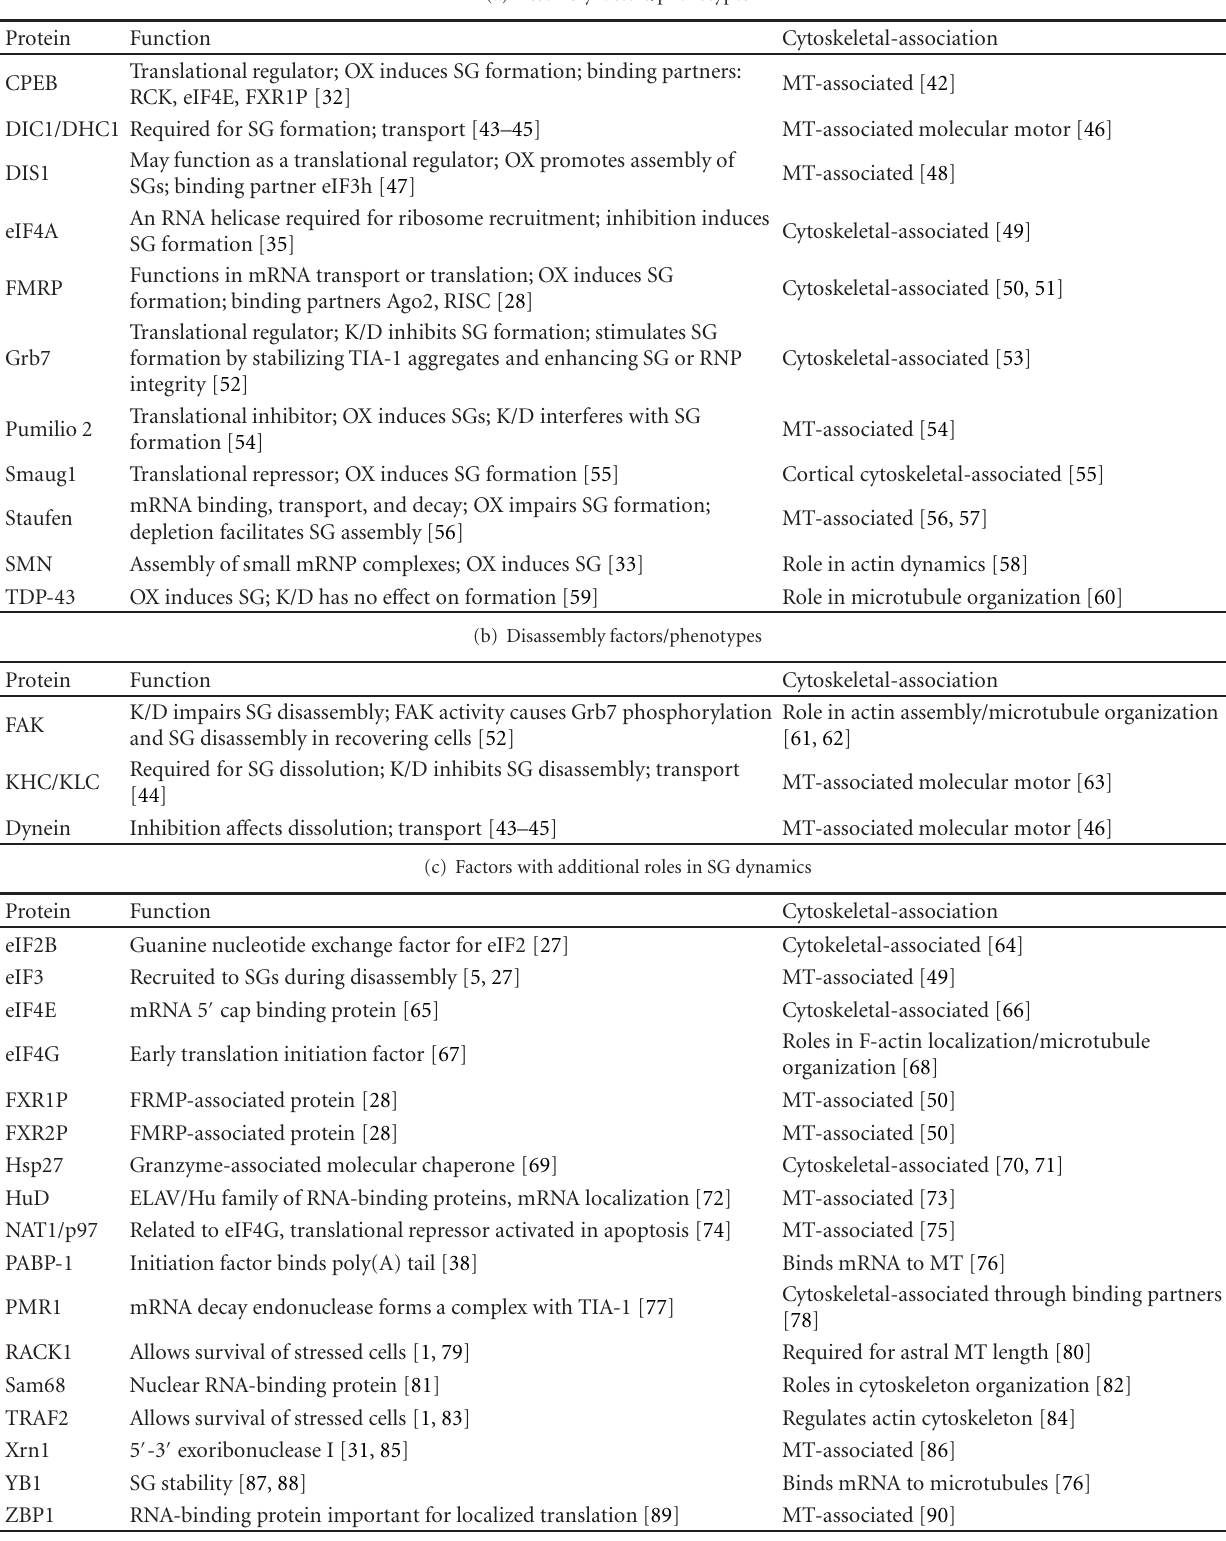
Table 1: Cytoskeletal-associated proteins that participate in SG dynamics. All proteins in this table localize to SGs. Assembly factors are shown in (a), disassembly factors are shown in (b), and proteins associated with SGs but with additional functions in SG dynamics are shown in (c). Cytoskeletal-associated proteins that functioned in SG coalescence were not identified, but publications demonstrating the importance of microtubule function in SG coalescence are suggestive of molecular motors aiding in this